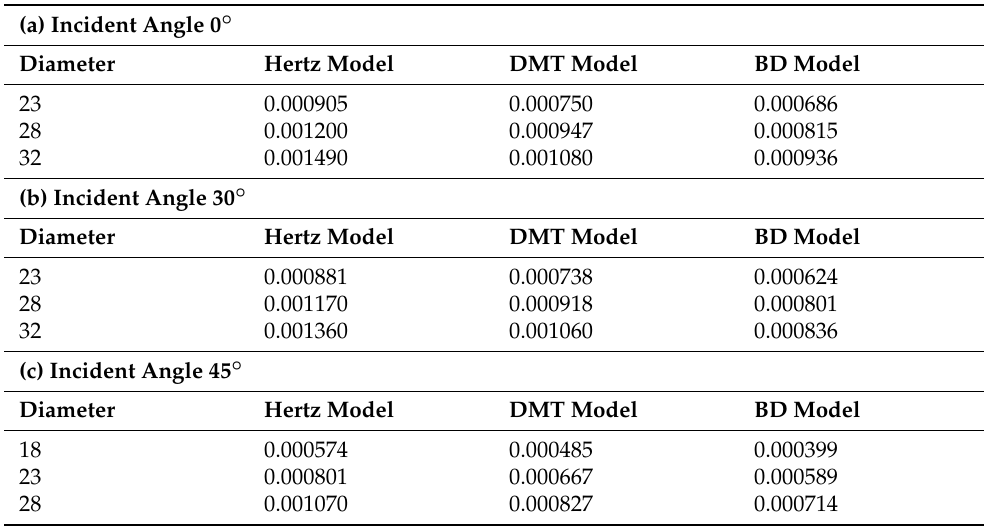
Figure 8. The relation between damping coefficient and normal restitution coefficient of Hertz model, DMT model, and BD model at different angles. Table 3. The critical damping coefficients of Hertz model, DMT model, and BD model at different incident